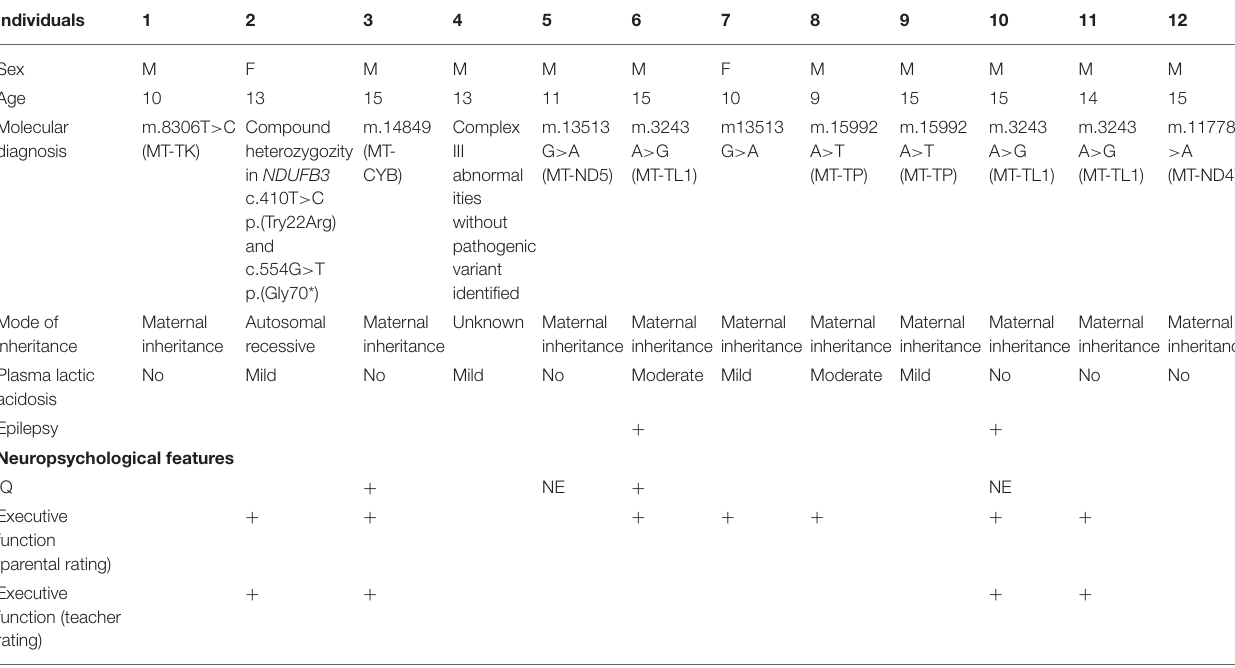
TABLE 1 | Molecular and neuropsychological characteristics of the 12 children from our cohort. Individuals